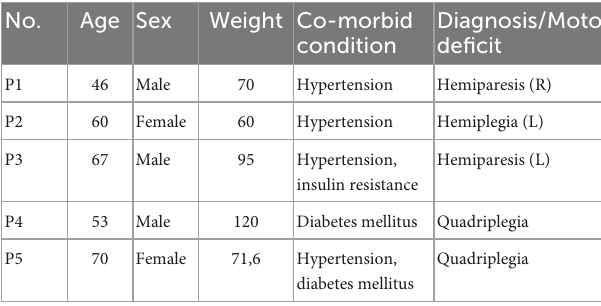
TABLE 1 Patients’ demographic data.